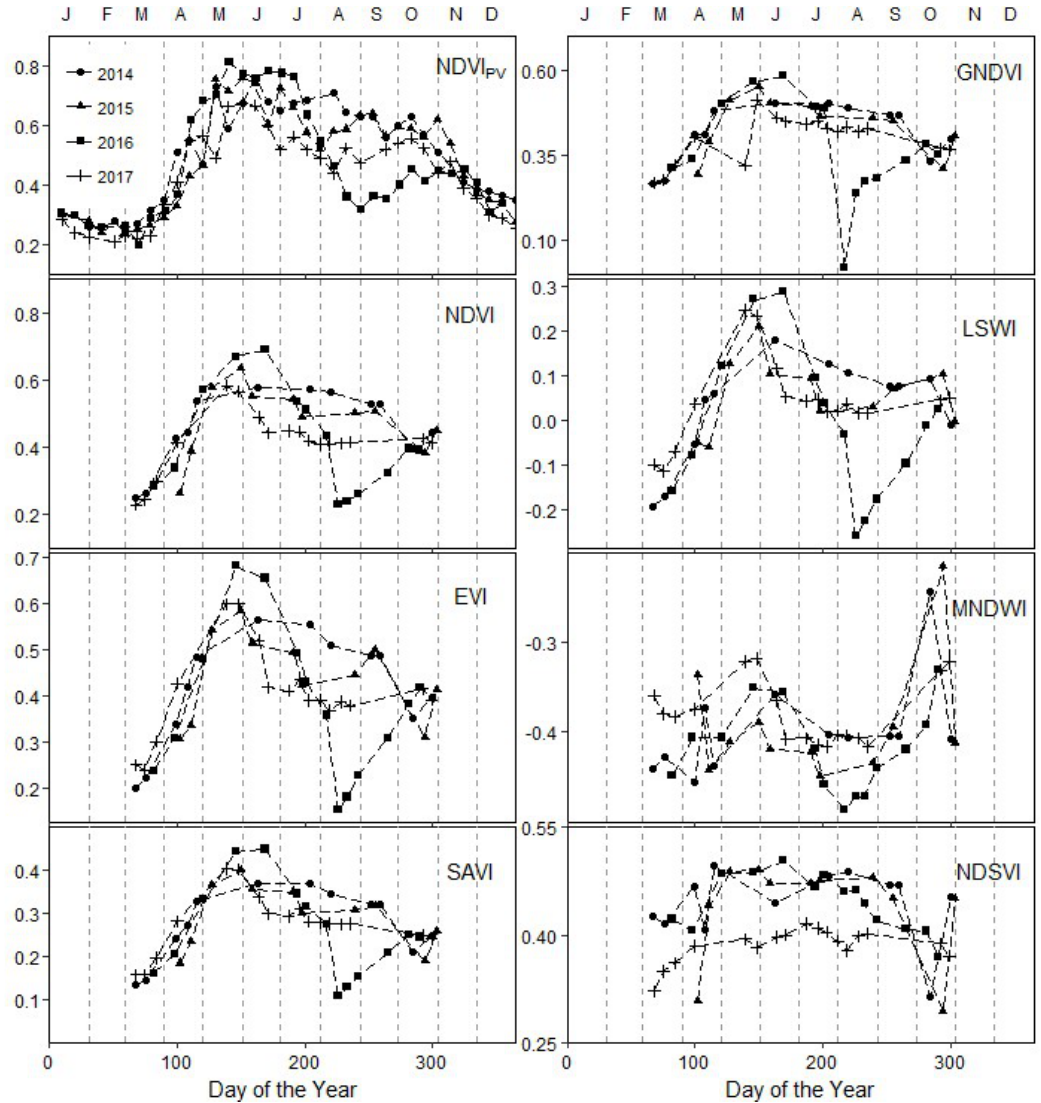
Figure 3. Temporal profile of vegetation indices calculated in this study (see Table 2). Different symbols represent different years.